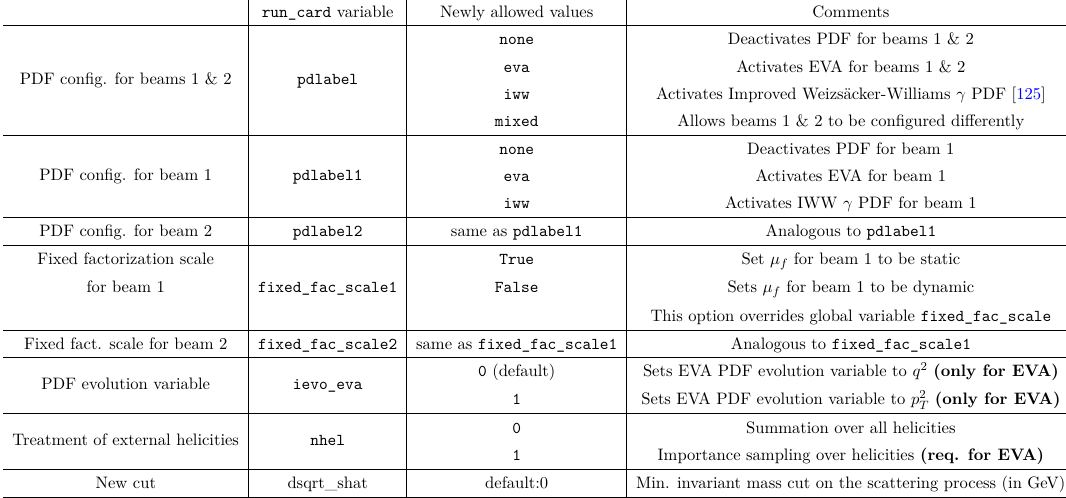
be selected using the run_card.dat parameter “ ievo_eva .” If this parameter is set to “ 0